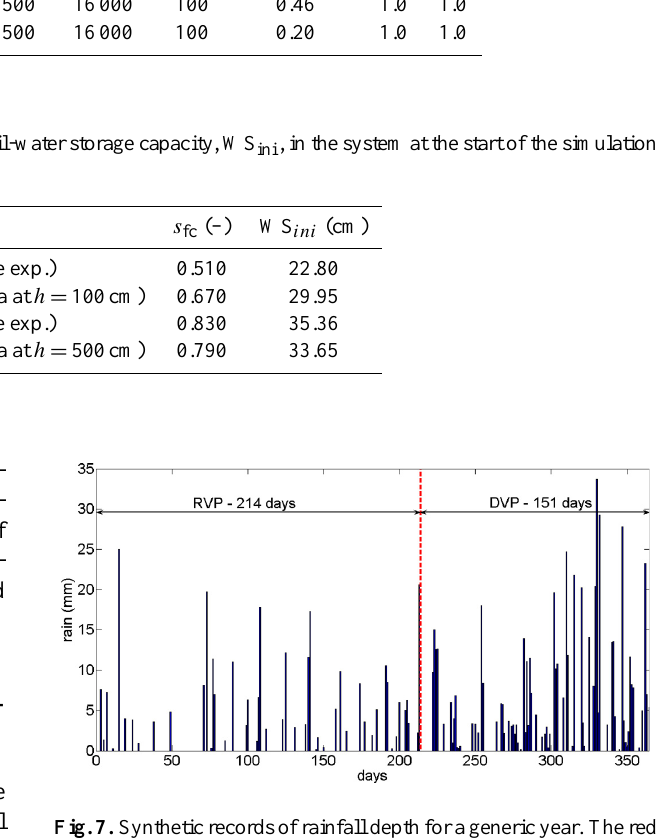
Fig. 7. Synthetic records of rainfall depth for a generic year. The red line separates the hydrologic year into the RVP and DVP